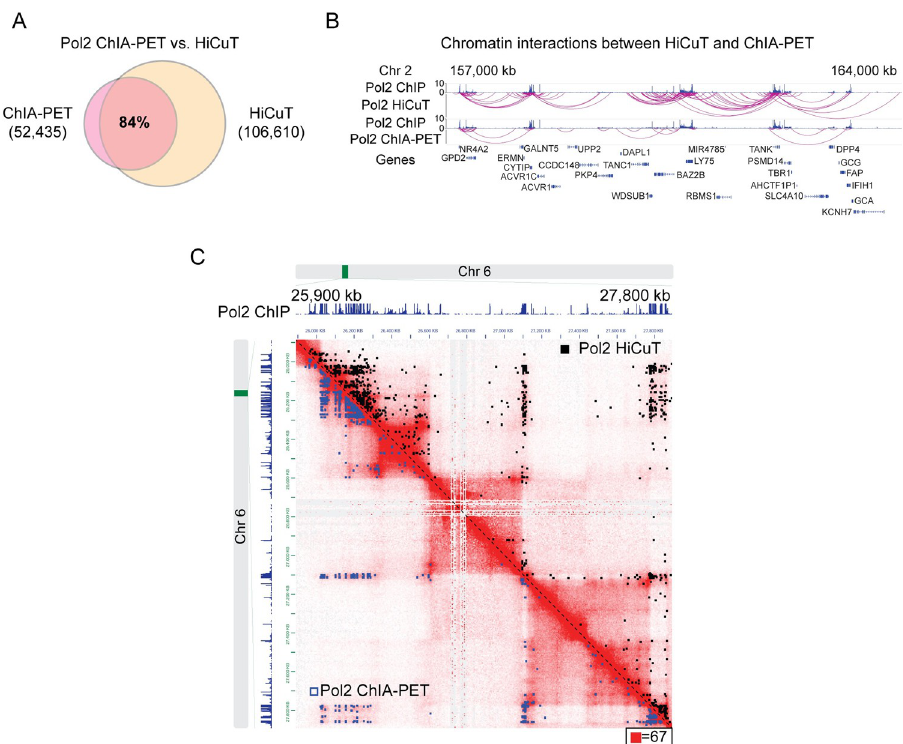
Fig 3. HiCuT identifies RNA Pol II mediated long-range interactions in GM12878 cells. (A) Comparison of shared long-range chromatin interactions between GM12878 RNA polymerase 2 (Pol2) HiCuT and ChIA-PET loops. The number of interactions for each dataset are displayed. (B) WashU Epigenome Browser view of chromatin interactions in GM12878 cells. The Pol2 ChIP tracks are from ENCODE GM12878 cells (GSM935386) followed by chromatin interactions identified by HiCuT or ChIA-PET. Chr, Chromosome [15,17].(C) RNAPol2 Hi-C contact map at 5 kb resolution superimposed with RNAPol2 HiCuT (upper right, black boxes) and RNAPol2 ChIA-PET interactions (lower left, blue boxes) [8,15].Maximum intensity is indicated in the lower right of each panel.